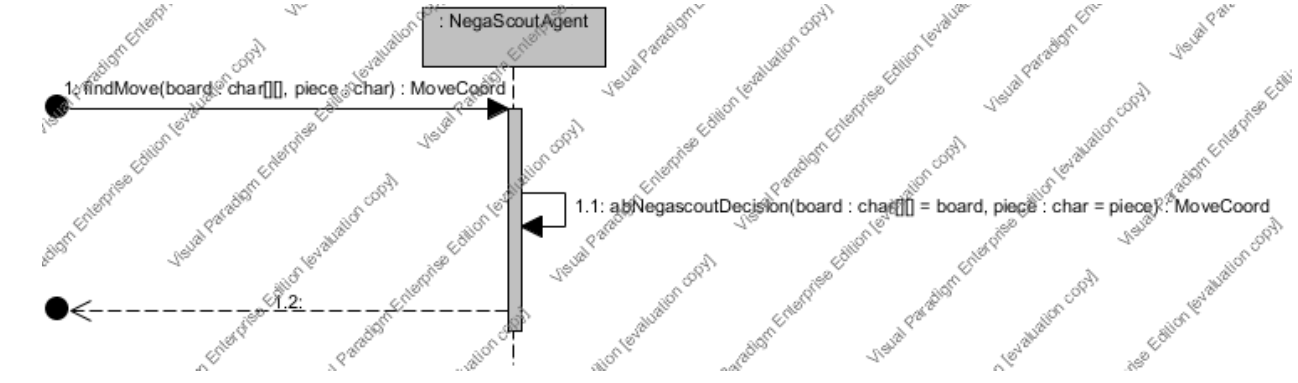
Fig. 4. The example of UML sequence